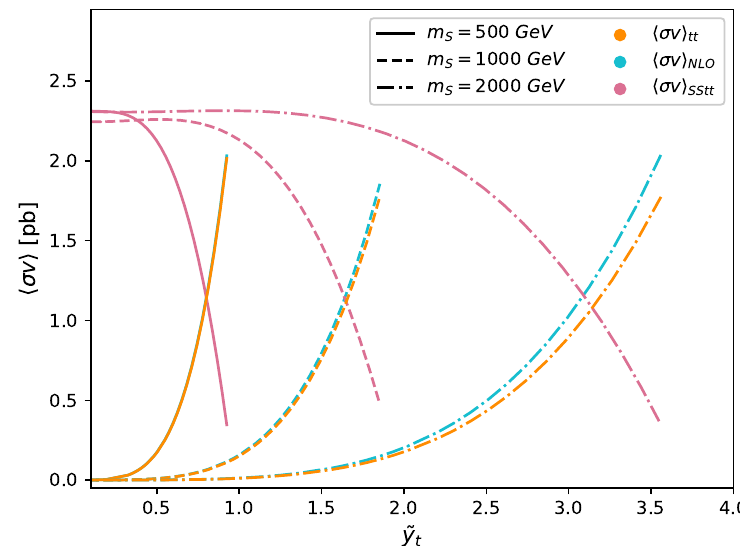
Figure 2 . A comparison of the impact of the different contributions to the thermally-averaged DM annihilation cross section for setups that yield the observed DM relic density. We vary the Yukawa coupling ˜ y t , have chosen three DM benchmark masses m S and fixed m T so that r = 0 . 6 . The last parameter ( C/ Λ ) has been fixed to match Planck’s results. This figure shows the interplay of the contributions from LO ( h σv i tt , orange), NLO ( h σv i NLO , blue), and contact interaction ( h σv i SStt , magenta)